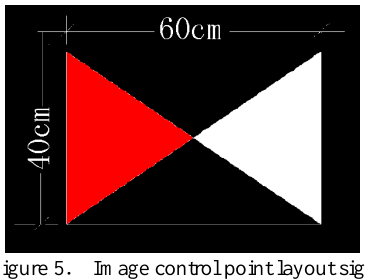
Figure 5 ． Image control point layout sign